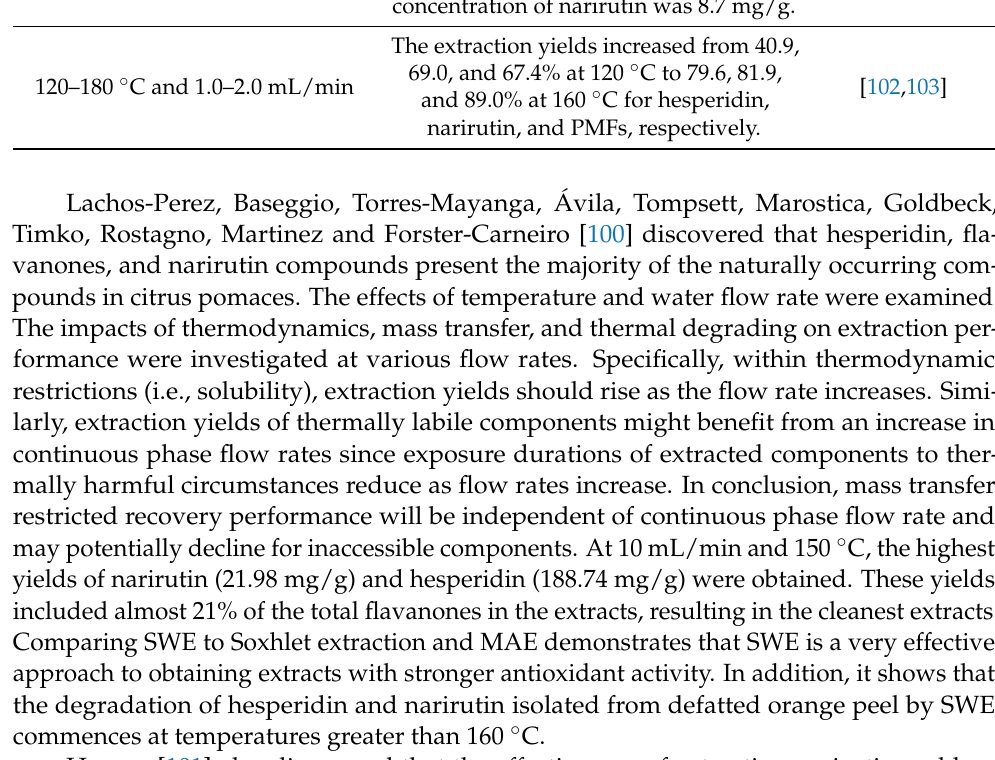
Table 5. The optimal parameters and outcomes in orange peel extraction by ScCO 2 . Optimum Conditions Outcomes Source The highest yields of narirutin and 10 mL/min and 150 ◦ C hesperidin were 21.98 mg/g and 188.74 mg/g, respectively. The maximum concentration of hesperidin was 46.96 mg/g after PEF treatment at 120 s with a temperature of 150 ◦ C and 15 min 150 ◦ C for 15 min, whereas the highest concentration of narirutin was 8.7 mg/g. The extraction yields increased from 40.9, 69.0, and 67.4% at 120 ◦ C to 79.6, 81.9, and 89.0% at 160 ◦ C for hesperidin, narirutin, and PMFs, respectively.